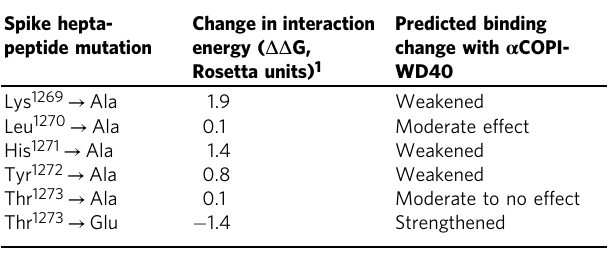
and highly disruptive substitutions have scores>1.2, while predicted substantial improved binding corresponds to scores< − 1.2. mutant demonstrated 1.5-fold slower association kinetics and 1.5- fold more rapid dissociation than for the wild-type hepta-peptide (Table 1). Compared to the Thr 1273 → Ala hepta-peptide, this Thr 1273 → Val mutant weakened binding by 2.8-fold while accel- erating α COPI-WD40 complex association and dissociation kinetics by 1.5 and 2.8-fold respectively (Table 1). These data suggest that the spike C-terminal Thr residue side-chain provides interactions that modulate dissociation of the complex with α COPI-WD40. COMMUNICATIONS BIOLOGY| (2022) 5:115